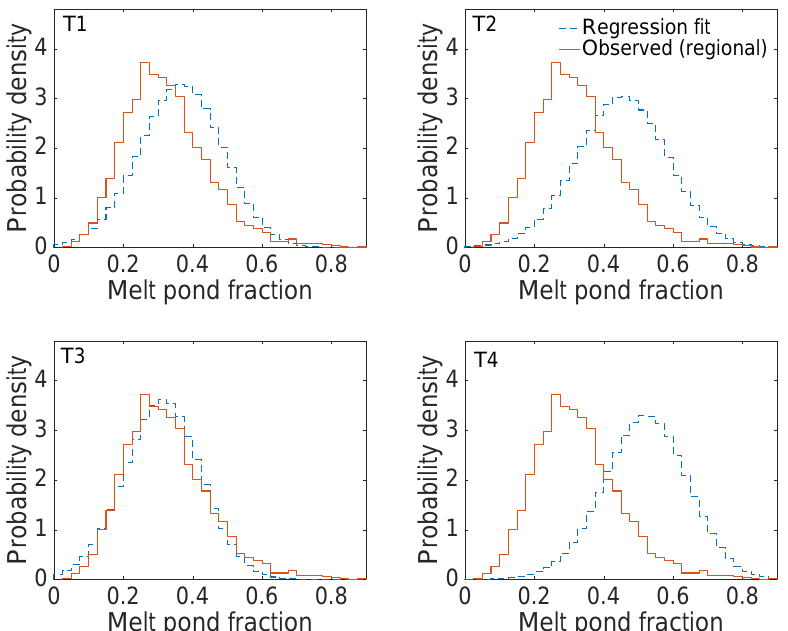
Figure 7. Probability density distributions of f MP for the four investigated scenes (T1–T4). Curves represent distributions produced from the R VV / HH -based regression fit with a 51 × 51 pixel window, and the observed distribution retrieved from all five helicopter flights.